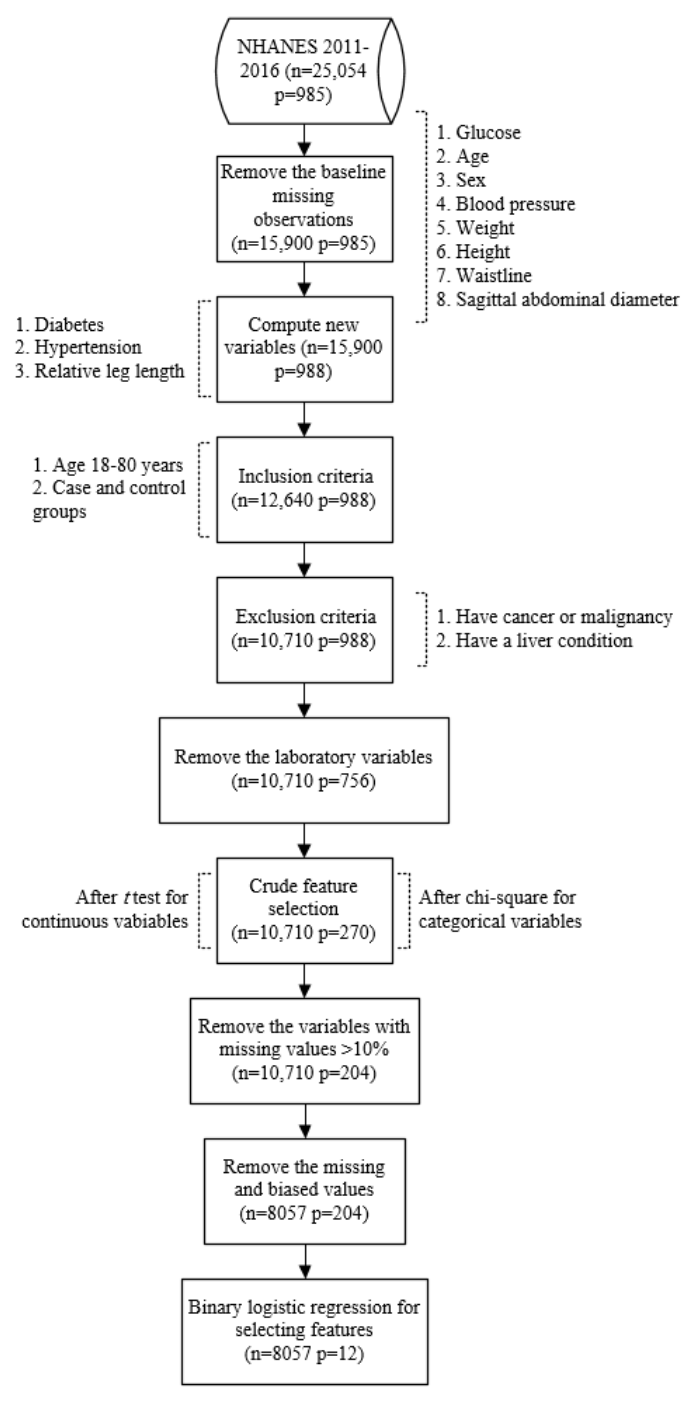
Figure 1. The data cleaning and feature selection process. Note that the feature selection process was run only in the NHANES 2011-2014 dataset. n: number of cases. p: number of